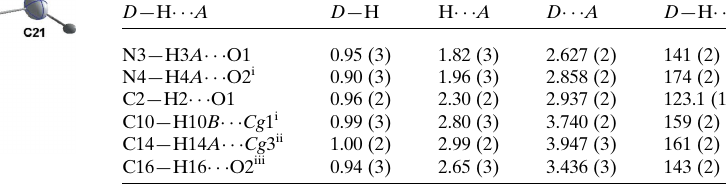
Figure 1 The molecular structure, with 50% probability displacement ellipsoids.